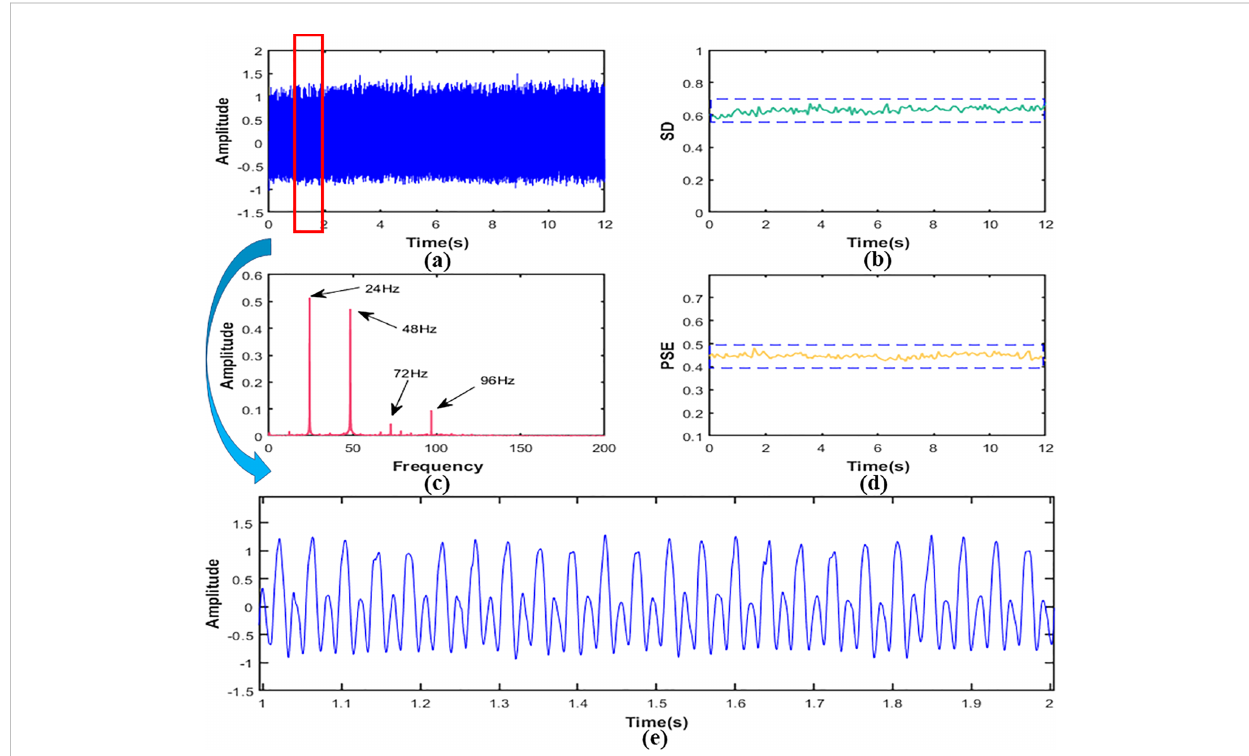
FIGURE 8 In working condition S1, signal (A) time domain fi gure, (B) the SD, (C) the PSE, (D) the FFT, (E) local ampli fi cation fi